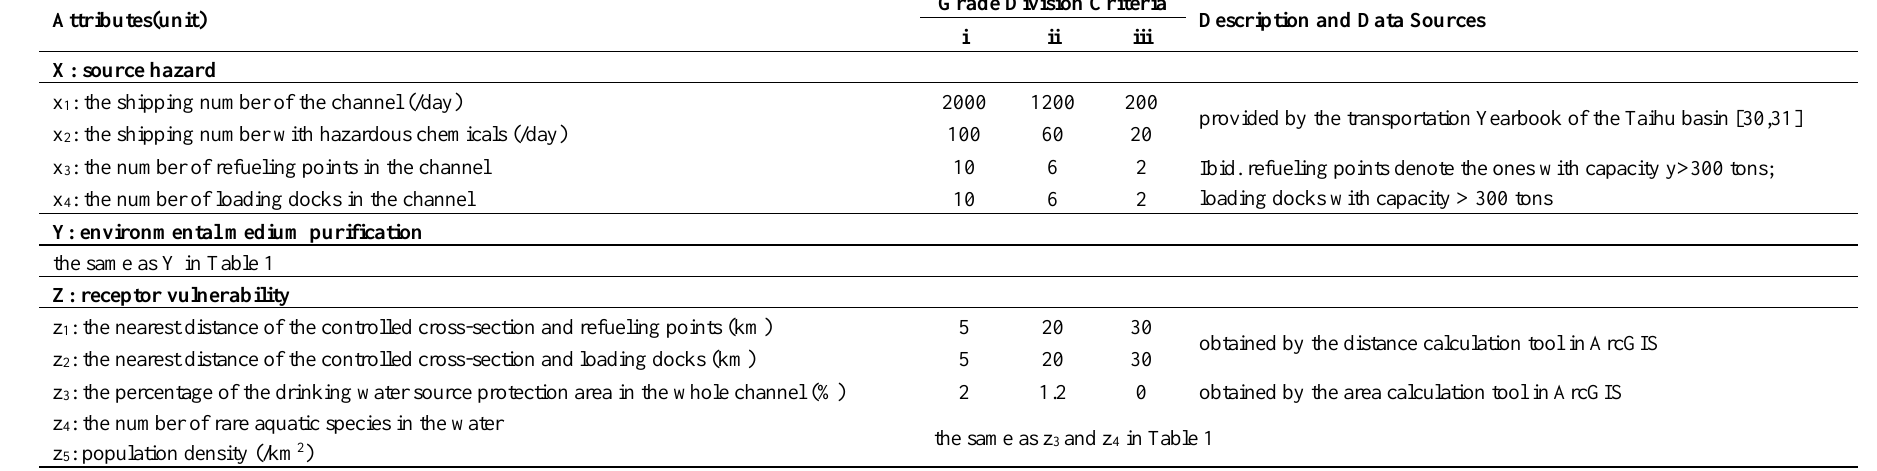
Table 3. Attributes of risk levels of WTRs and their grade division